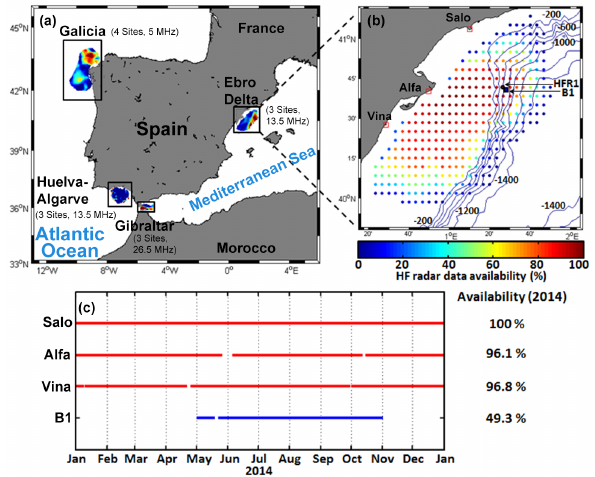
Figure 1. (a) HF coastal radar network currently operated by Puer- tos del Estado; (b) HF radar deployed at the Ebro delta, composed of three sites: Salou (SALO), Alfacada (ALFA) and Vinaroz (VINA). Colored dots denote the temporal coverage in percent of HF radar surface current total vectors for the entire year of 2014. Isobath depths are labeled every 200m. The location of the Tarragona buoy (B1) is marked with filled blue squares. HFR1 denotes the radar grid point closest to the B1 position. (c) Timelines of HF radar sites (red) and B1 buoy (blue) current data availability for